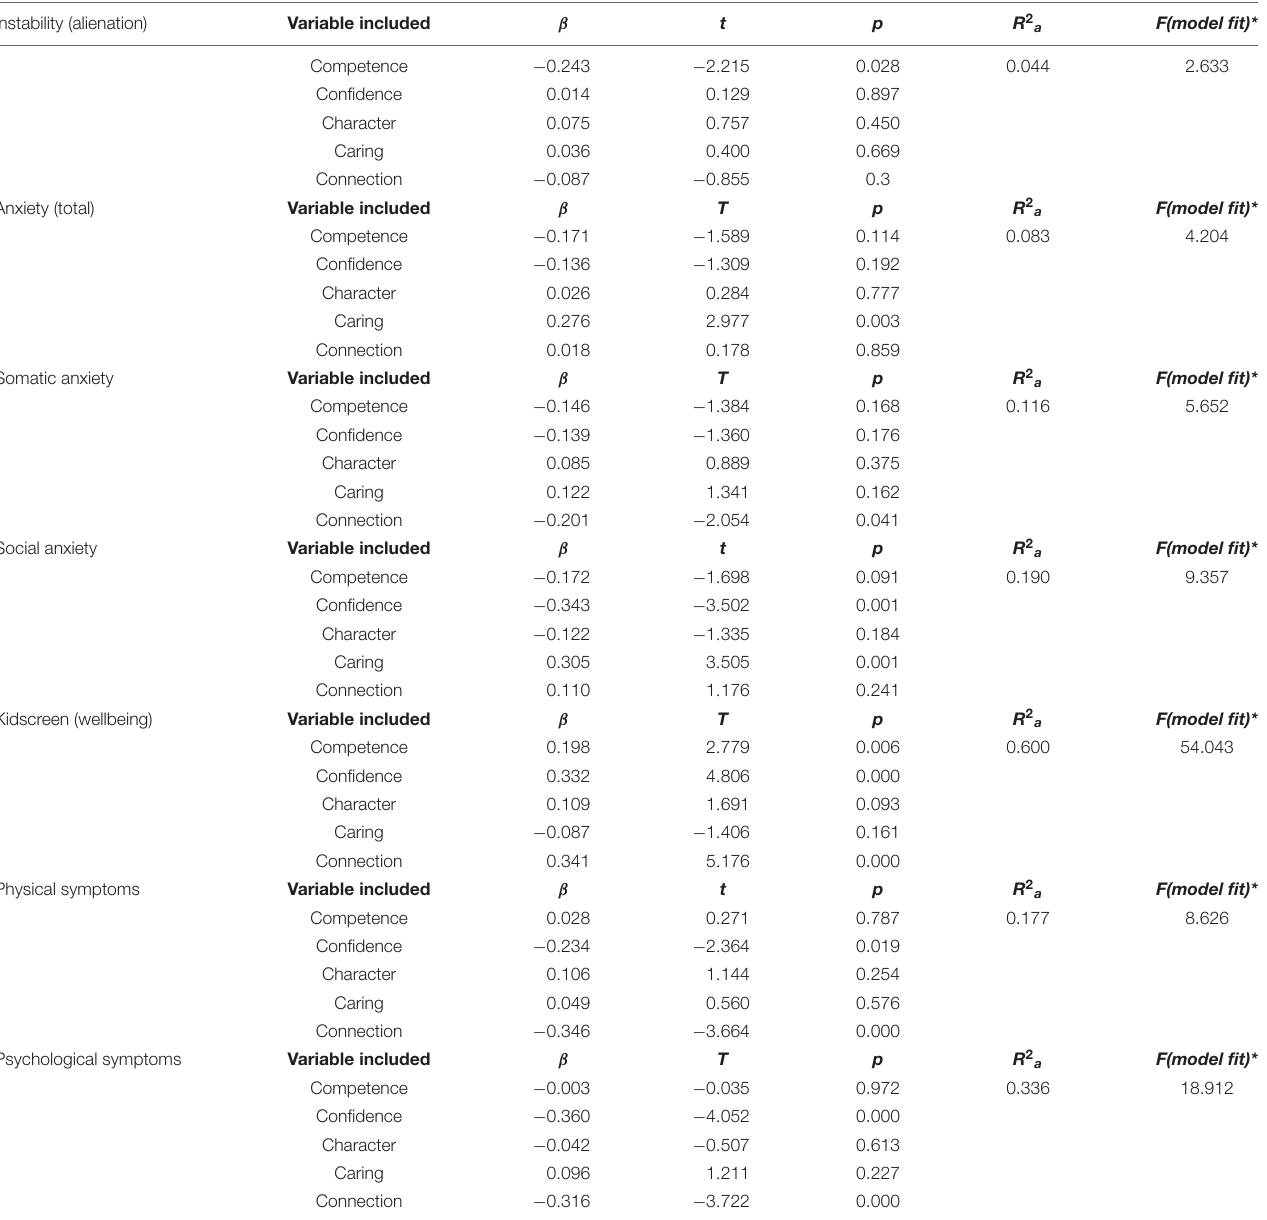
TABLE 4 | Multiple linear